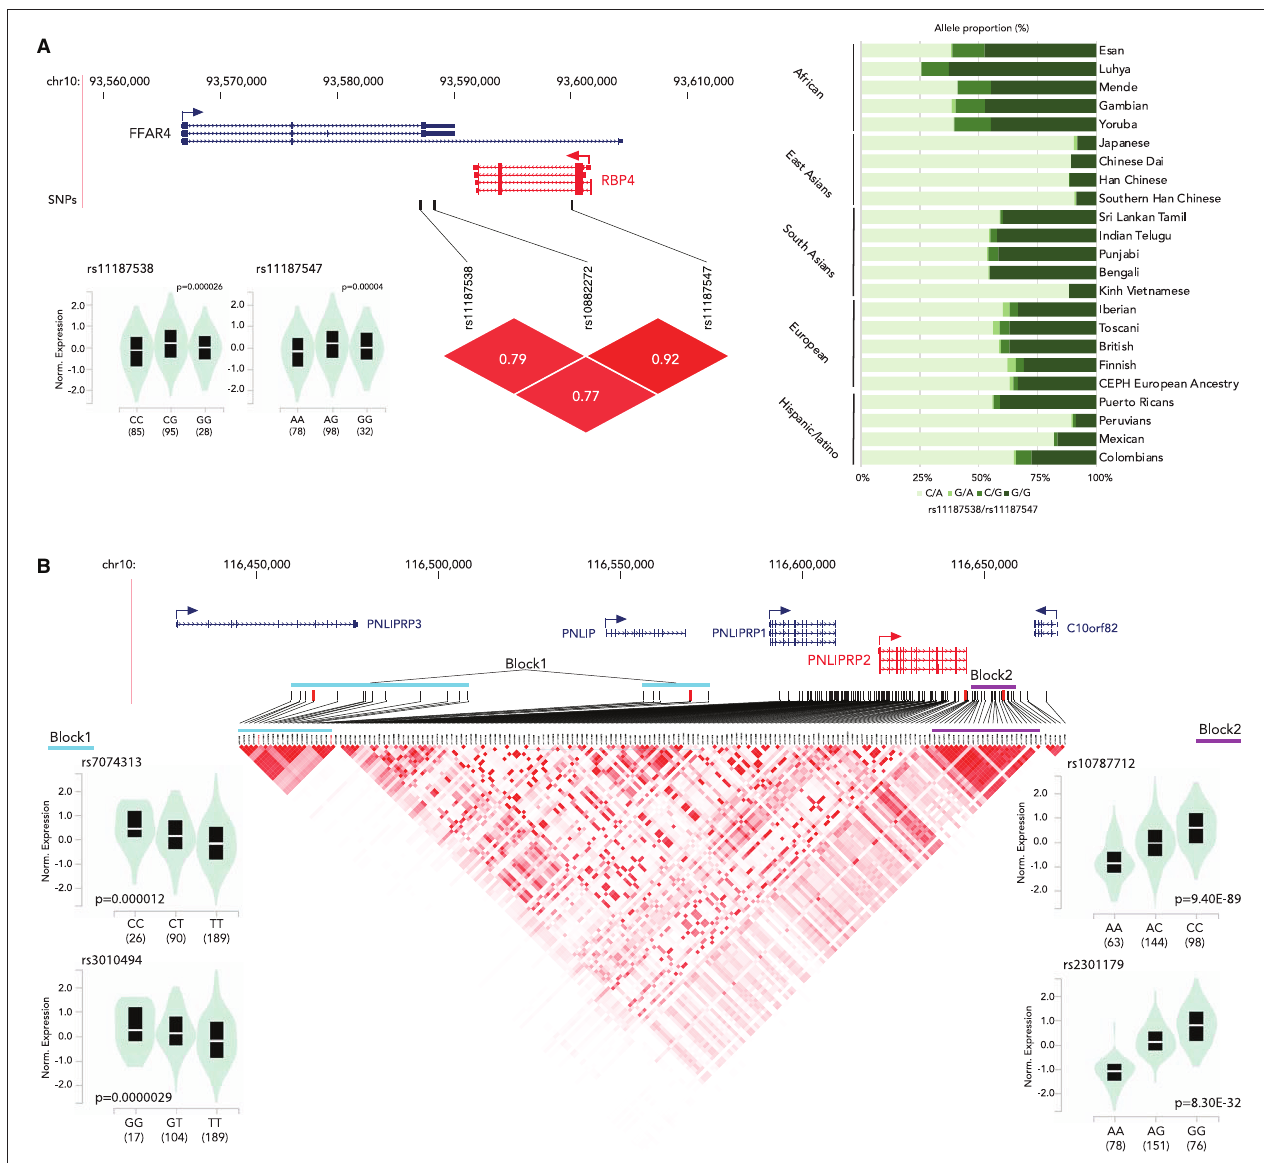
FIGURE 2 | Summary of eQTLs of RBP4 (A) and PNLIPRP2 (B) . (A) (top) Locations of eQTLs in RBP4; (bottom left) normalized expression status of RBP4 by genotype; (bottom right) an LD plot; (right) haplotype proportion by race/ethnicity group. (B) (top) Locations of eQTLs in PNLIPRP2; (bottom left) normalized expression status of PNLIPRP2 by genotype (block 1); (bottom center) a Linkage disequilibrium (LD) plot of eQTLs; (bottom right) normalized expression status of PNLIPRP2 by genotype (block